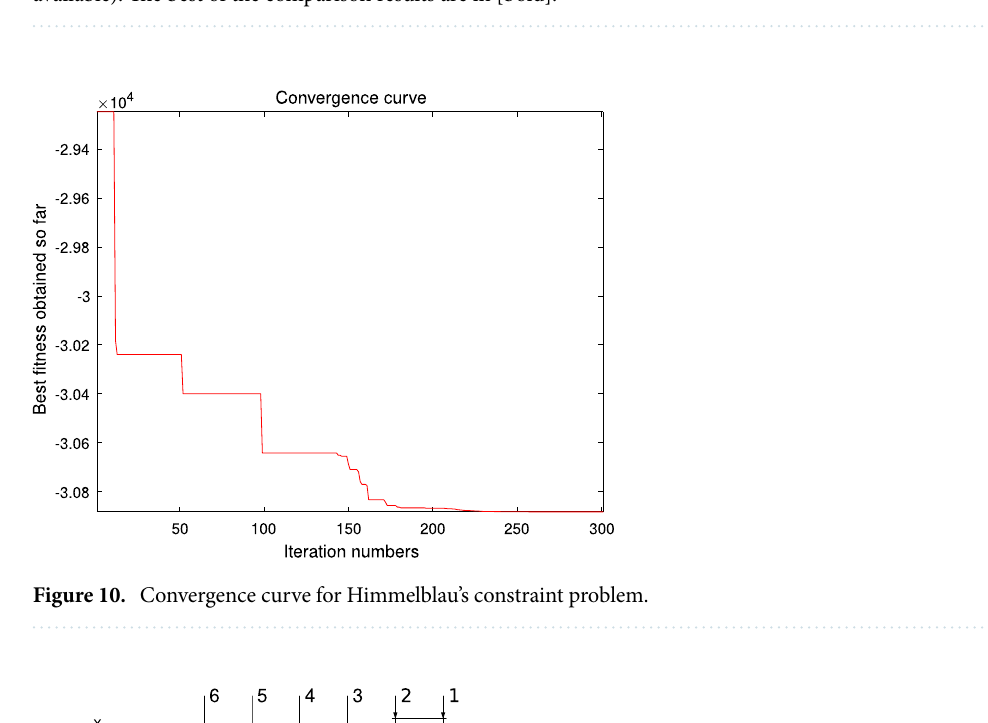
Table 16. Comparative results of LFGOA with other methods for Himmelblau’s (N/A stands for not available). The best of the comparison results are in [bold].